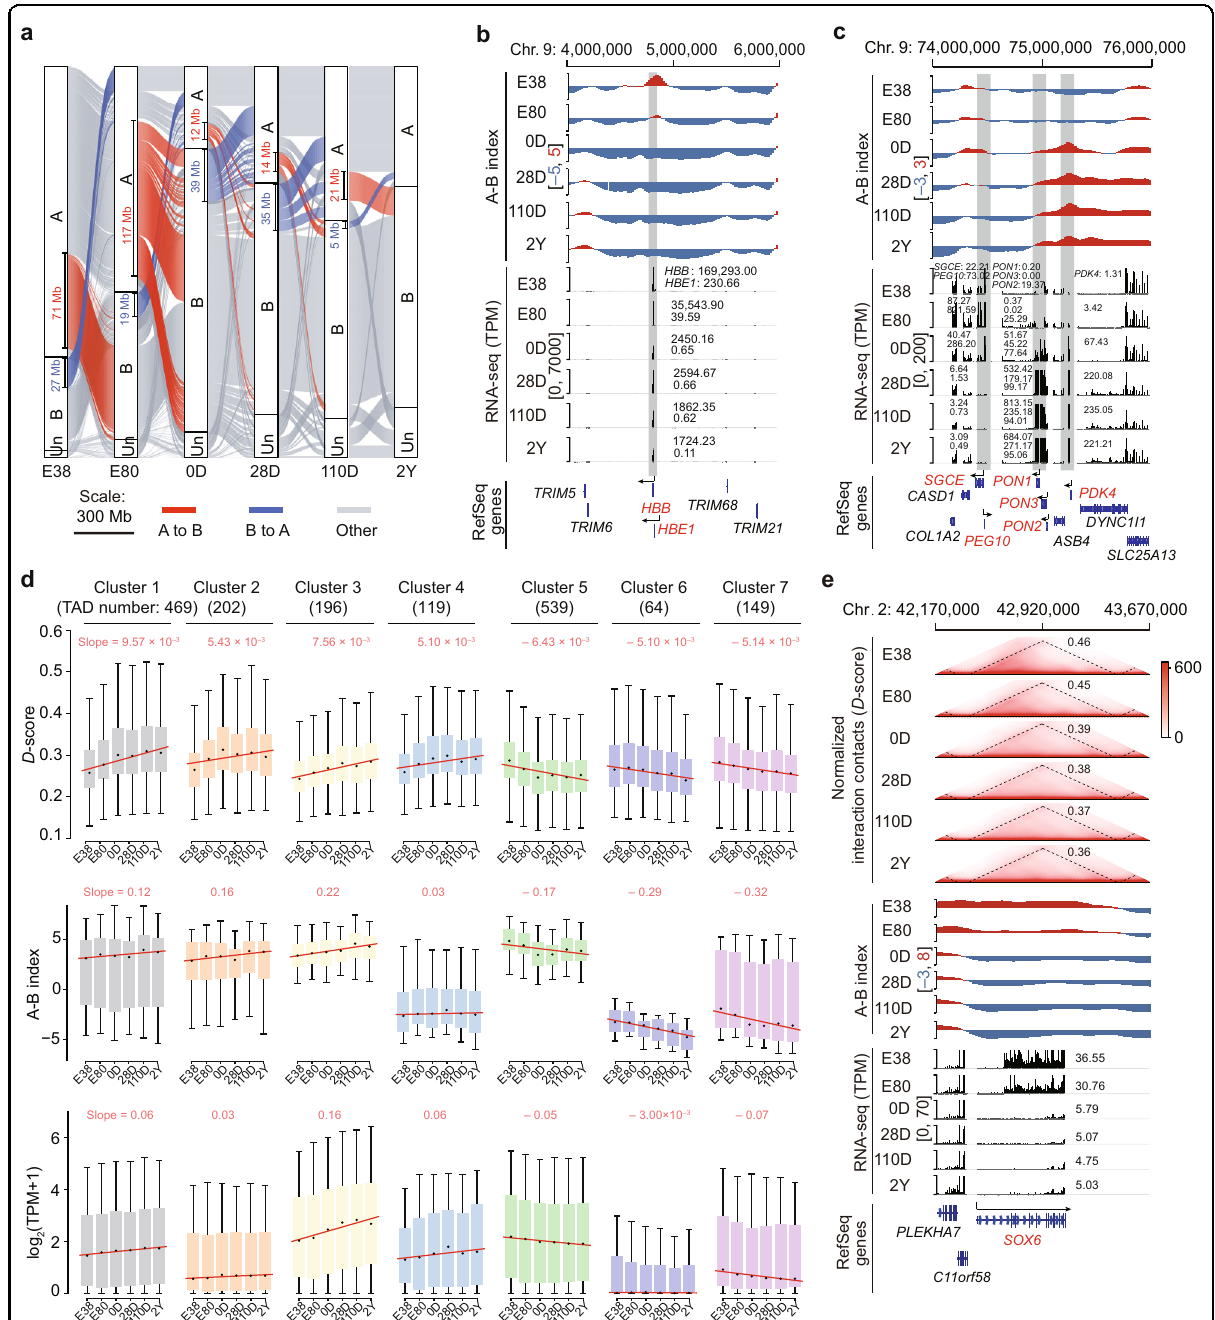
Fig. 3 Gene expression affected by shifts in chromatin architecture during liver development. a Alluvial representation plot of compartment switching during development. Boxes indicate the length of the genomic regions. ‘ Un ’ represents genomic regions with uncategorized compartmental status. b, c Dynamic compartment status and corresponding gene expression for HBB and HBE1 ( b ) and SGCE , PEG10 , PDK4, PON-1 , -2 , and -3 ( c ). d Varying TAD connectivity largely coincided with changes in compartmentalization and gene expression during development. Among the seven TAD clusters with developmental stage-dependent D -score changes, we found that clusters 1 – 4 and 5 – 7 were gradually elevated or reduced, respectively. The slopes of the fi tted regression lines are also shown. e Representative TADs (containing SOX6 ) with reduced D -scores during